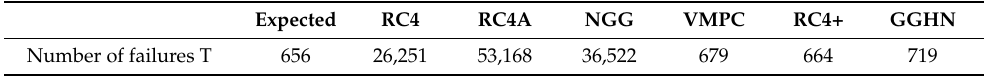
Table 1. Expected value and observed values for each cipher in